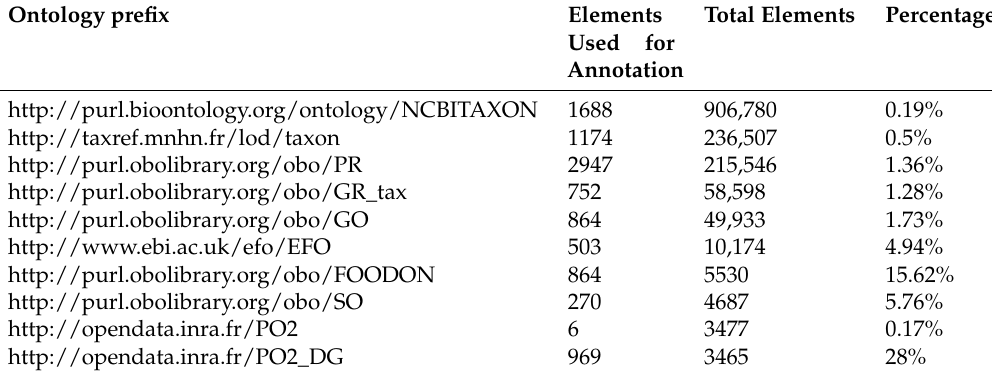
Table 4. Set of the top-ten largest ontologies indicating, for each one, how many elements were used for annotating articles, the size of the ontology, and a percentage indicating the portion of the ontology used in